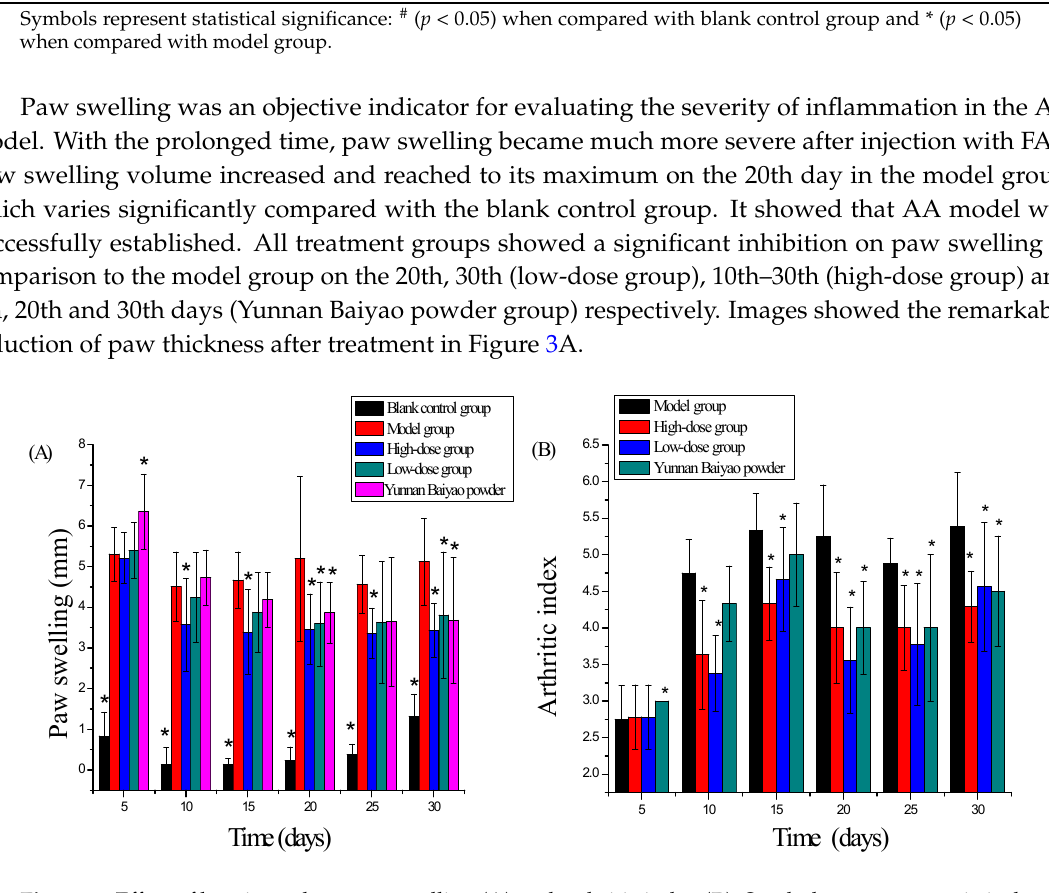
Table 1. Effect of brucine gel on body weight (BW).